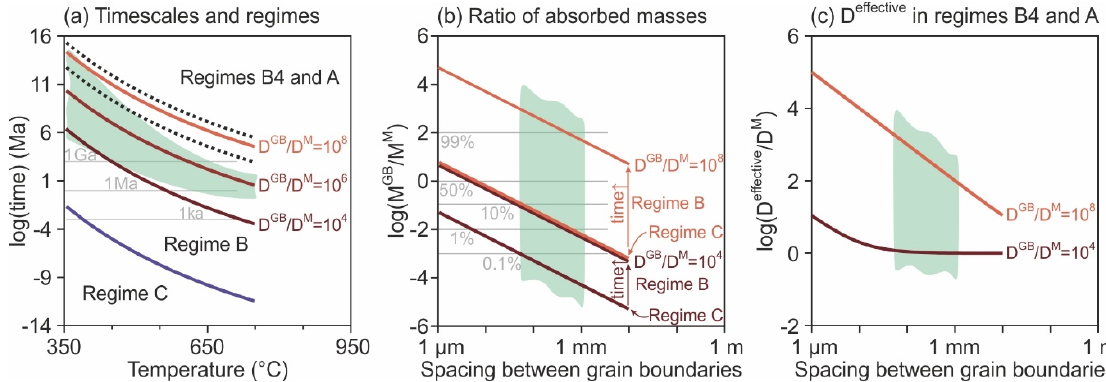
Figure 8. Effects of the abundance and diffusion properties of grain boundaries on the transport of Pb in polycrystalline alkali feldspar. ( a ) The relationship between time, temperature and the kinetic regime of diffusion in polycrystalline alkali feldspar depending on the assumed diffusivity of Pb along grain boundaries. The blue line shows t’, the brown to orange lines show t’’ for different D GB /D M ratios, the lower and upper black dotted lines show time when Harrison’s condition for regime A becomes satisfied for crystal sizes of 50 μ m and 1 mm, respectively (see text for details). The green region indicates the range of D GB /D M ratios for K and Ca in feldspars at a given temperature [52,67]. The grey lines indicate 1 ka, 1 Ma and 1 Ga of isothermal residence. ( b ) The contribution of grain boundaries to the total absorption of Pb (expressed in a form of M GB /M M ratios) depending on the spacing between grain boundaries for different D GB /D M ratios and kinetic regimes. The lower line for each D GB /D M ratio corresponds to regime C, while the upper line corresponds to regime B at the time of transition to regimes B4 or A. M GB /M M ratios gradually increase from the lower line to the upper line while within regime B. Green shading highlights crystal sizes ranging from 50 μ m to 1 mm. The grey lines indicate the fraction of the total absorbed mass that was absorbed by grain boundaries. ( c ) The relationship between D effective and the spacing between grain boundaries for different D GB /D M ratios. The green field shows crystal sizes that range from 50 μ m to 1 mm.